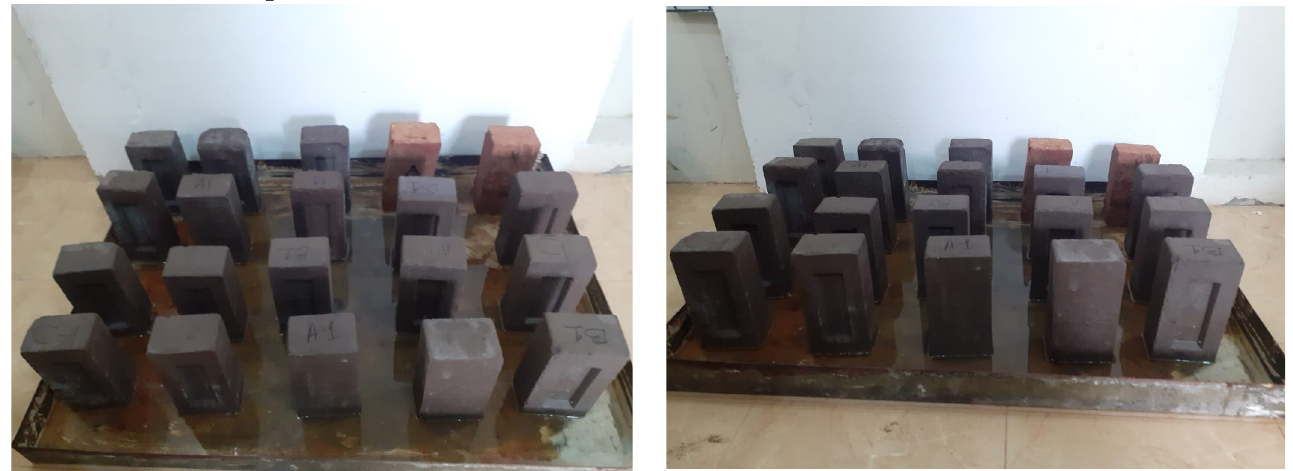
Figure 15. Efflorescence of the brick samples.